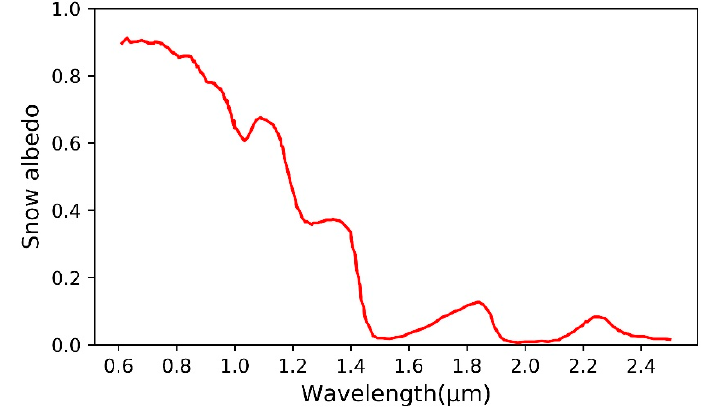
Figure A2. Typical spectral albedo curve for snow [60].